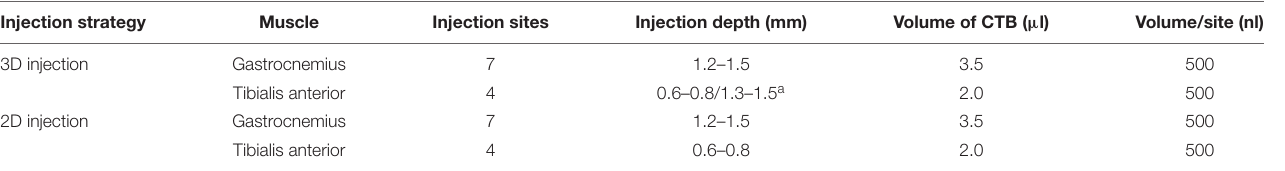
FIGURE 1 | Illustration of intramuscular injection strategies based on the motor endplate (MEP) distributions. (A–F) The location of injection sites based on the 3D distributions of MEPs in the gastrocnemius and tibialis anterior. Panels (A,B) and (D,E) show the 3D distribution of MEPs of the gastrocnemius and tibialis anterior, respectively. Panels (C,F) show the injection sites for the 3D intramuscular injection of the gastrocnemius and tibialis anterior. The asterisks represent the injection sites. Note that the injection depth of the yellow site on the tibialis anterior is different from the other three sites. MGL, gastrocnemius lateralis; MGM, gastrocnemius medialis; DS, dorsal surface; BS, bone surface. Scale bar: 1,000 µ m. (G–J) The location of injection sites according to the MEP regions on the muscle surface. Panels (G,I) show the MEP regions on the surfaces of the gastrocnemius and tibialis anterior following an acetylcholinesterase histochemical reaction. The injection sites along the surficial MEPs are shown in panels (H,J) . TABLE 1 | Details for 3D and 2D intramuscular injection